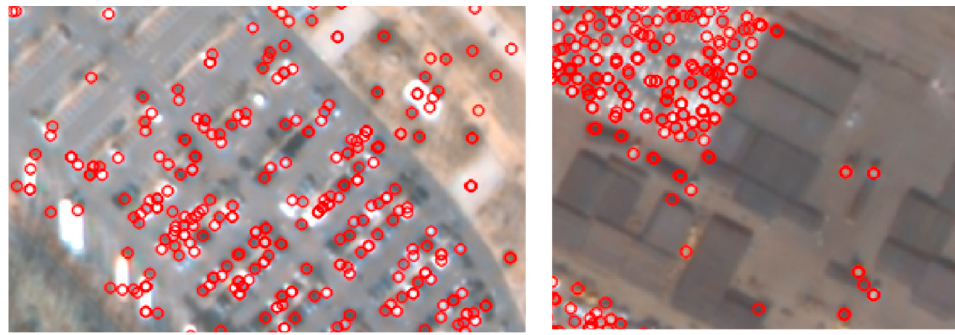
Figure 13. Enlarged feature-point extraction results.